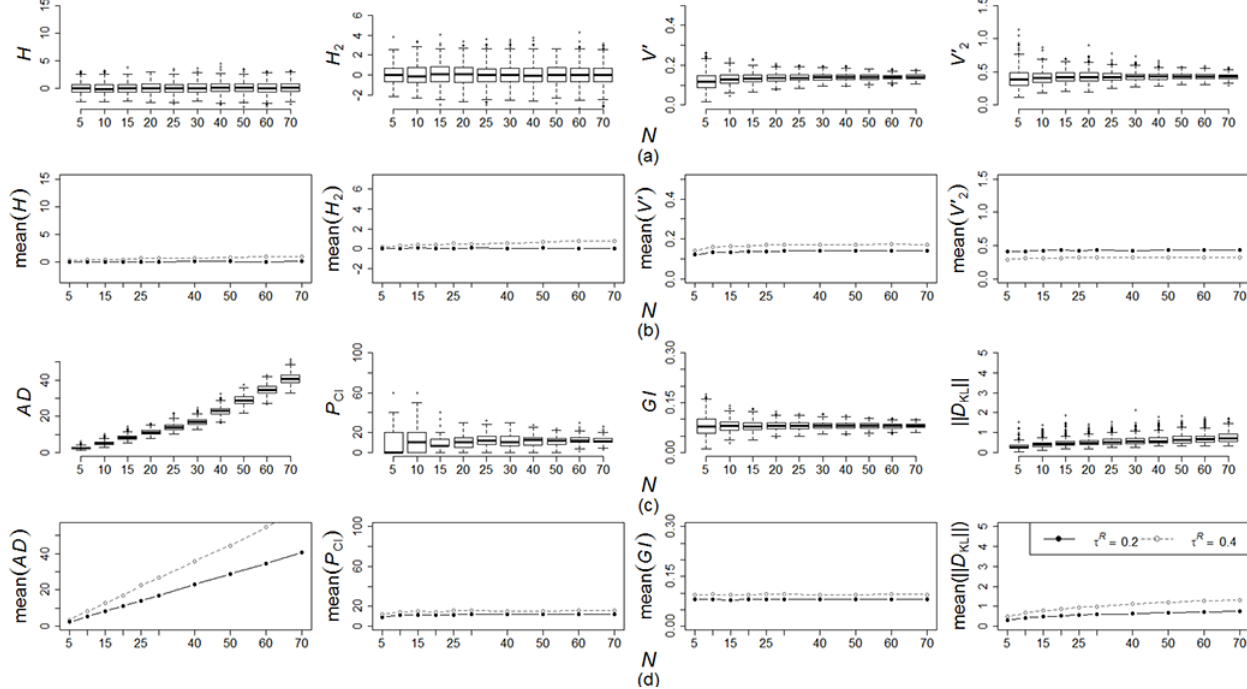
Figure 2. Sensitivity analysis: (a, c) box plots of the heterogeneity measures for N s = 500 simulations of the reference region ( n = 30 and τ R = 0.2), with a heterogeneity rate γ = 0%, varying the number of sites N ; and (b, d) comparison of the corresponding mean with the one obtained by considering τ R =